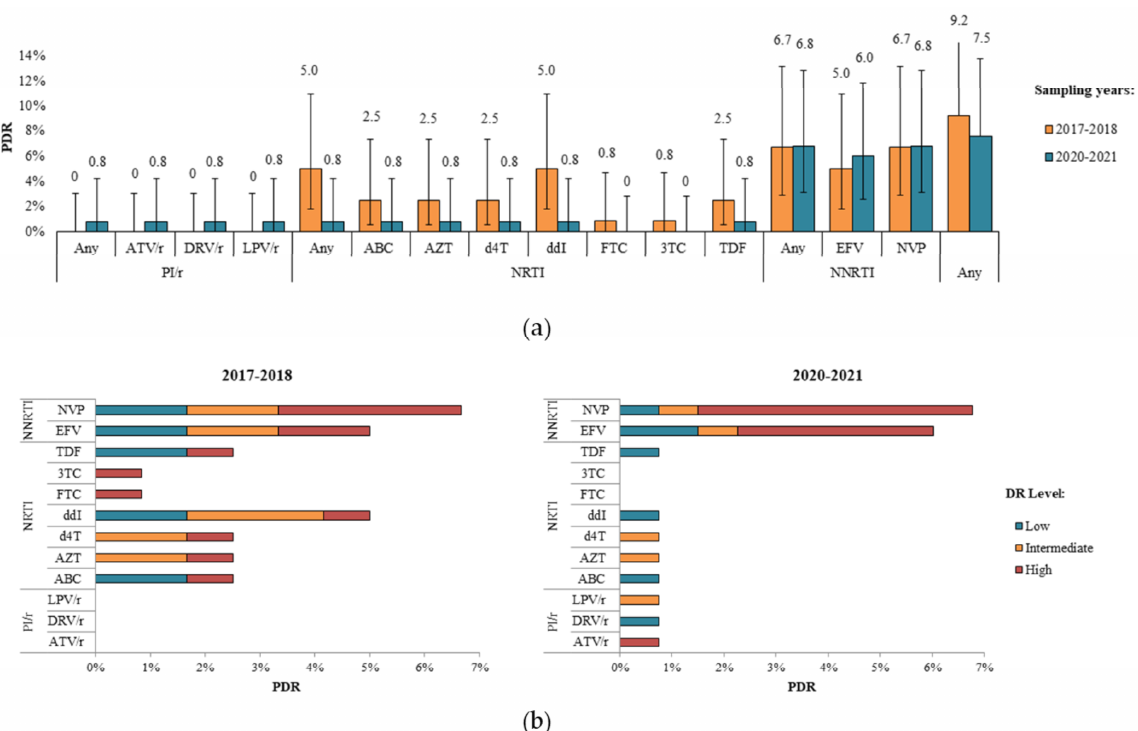
Figure 2. PDR prevalence in Armenia in the 2017–2018 and 2020–2021 sampling years for ( a ) antiretroviral drugs and ( b ) antiretroviral drugs with DR levels. Error bars represent 95% CIs. Abbreviations: ATV/r, atazanavir/ritonavir; DRV/r, darunavir/ritonavir; LPV/r, lopinavir/ritonavir; ABC,